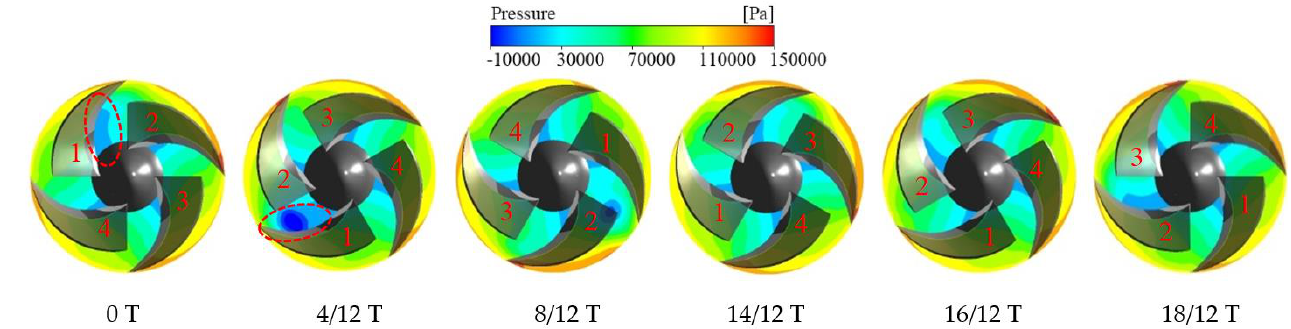
Figure 8. Pressure nephogram of impeller outlet section at different time ( δ = 0.2 mm).